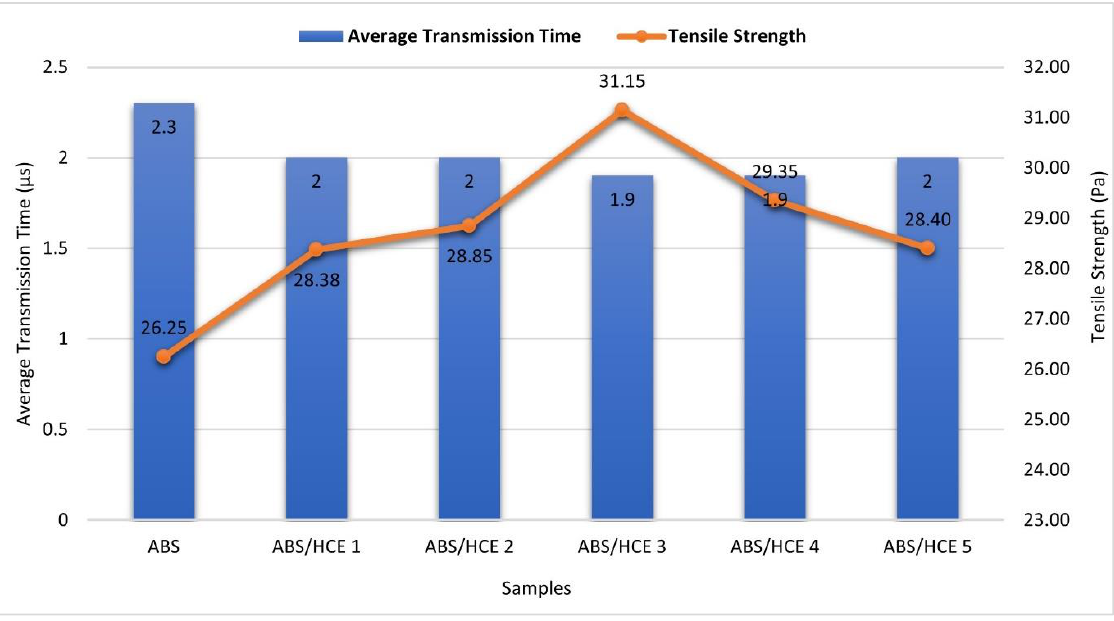
Figure 12. Correlation between average transmission times and tensile strength for ABS/HCE composites.